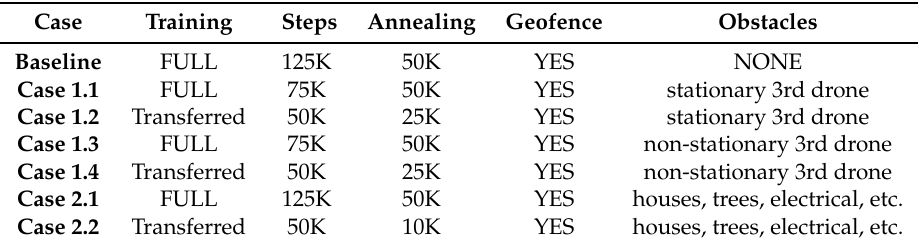
Table 3. Training cases